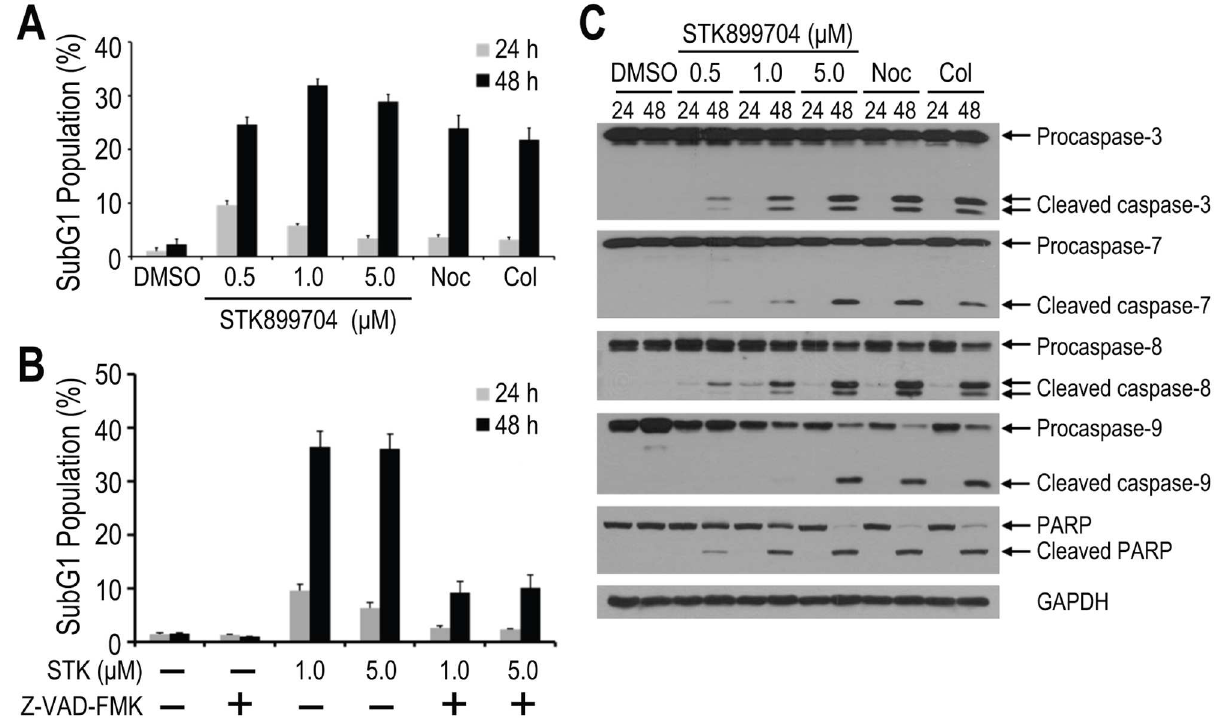
Fig 4. STK899704 triggered programmed cell death. (A) Effect of STK899704on DNA fragmentation. HeLa cells were treated with 200 ng/ml nocodazole (Noc), 100 nM colchicine(Col), or indicatedconcentrations of STK899704.Treated cells were then stainedwith PI and processedfor cell cycle analysisat 24 and 48 h. (B) Antagonistic effect of Z-VAD-FMK on STK899704-inducedcell death. HeLa cells were treated with DMSO or STK899704 (STK, 1 or 5 μ M) in the presenceor absenceof Z-VAD-FMK (50 μ M). Cells were then stainedwith PI and processedfor cell cycle analysisat 24 and 48 h. (C) Effect of STK899704on the levels of activated caspases. HeLa cells were treated as in (A) and then subjectedto immunoblot analysiswith antibodiesagainstcaspase-3,caspase-7,caspase-8, caspase-9,and PARP. GAPDH was used as a loading control. Each bar indicatesmean ± SD of subG 1 population from three independent experiments.